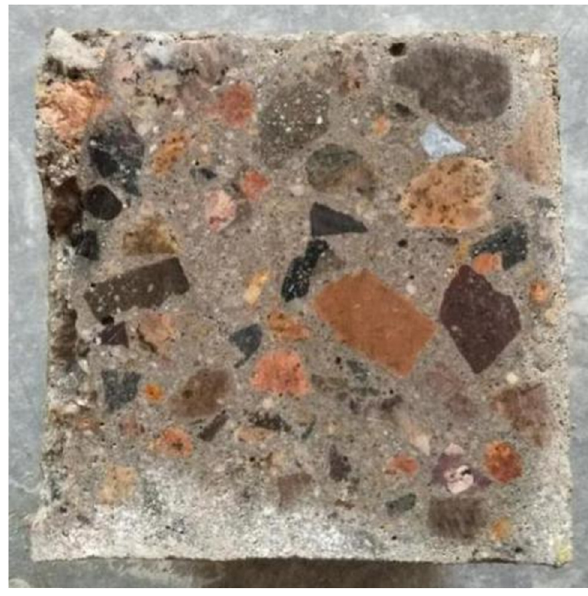
Figure 15: Cutting slice of recycled concrete.